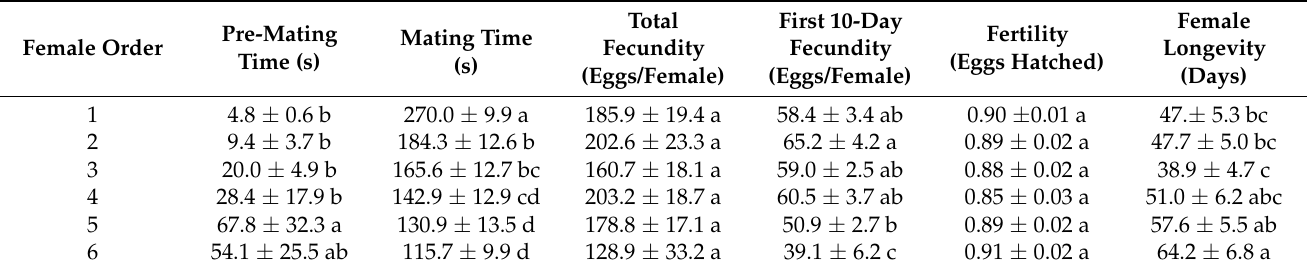
Table 1. Effect of female order on mating time, fecundity, fertility and longevity of Orius laevigatus females mated successively with the same